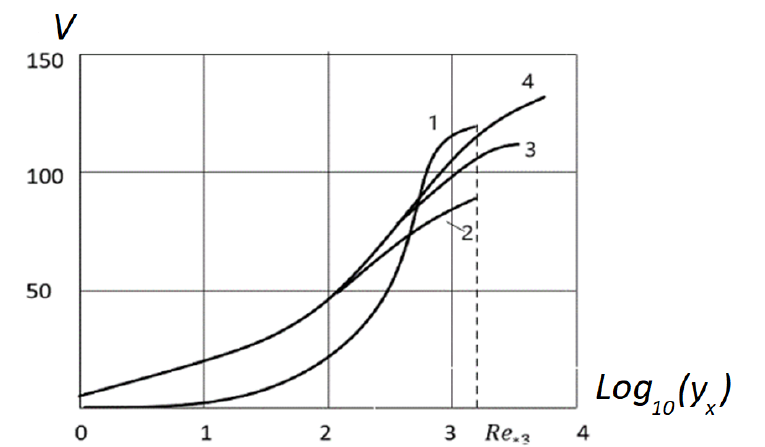
Figure 7. Velocity profiles: 1—“laminar-type” one for Re ∗ = 1625; 2—Virk profile for Re ∗ = 1625; 3, 4—Virk profiles for Re ∗ = 5000 and 8000,